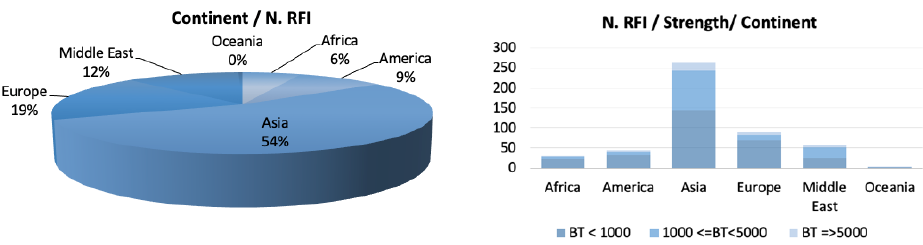
Figure 10. RFI Statistics in July 2022.